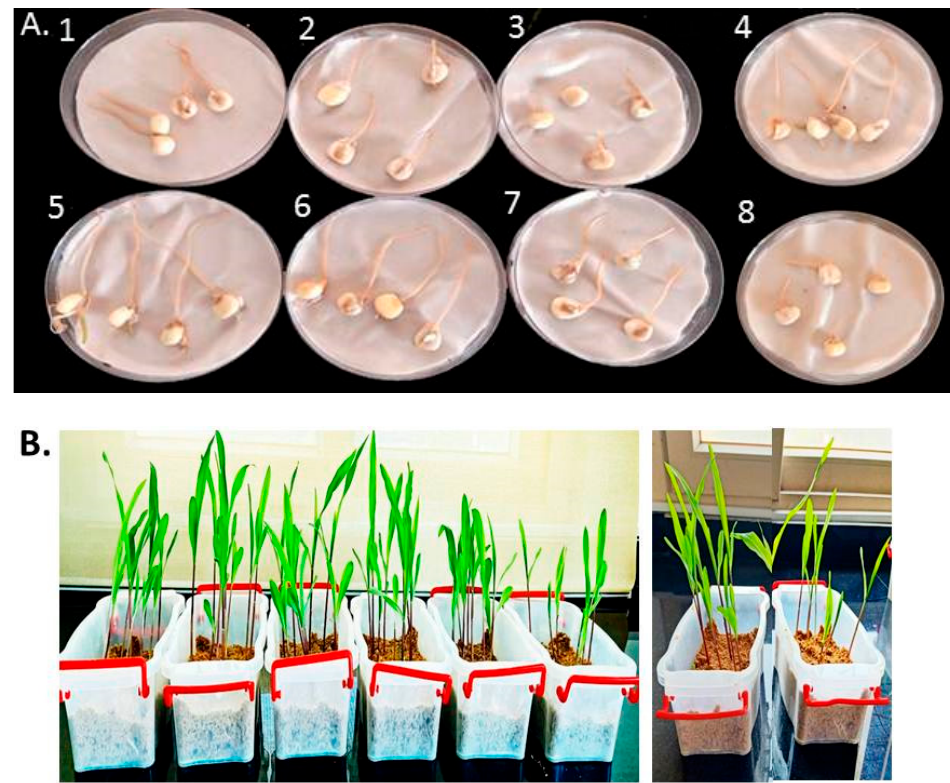
Figure 3. Representative seeds 4 days after treatment with the various L-CNPs concentrations (25, 50, 100, and 500) and refer to L-CNPs concentrations applied to seed for priming ( A ); representative samples 14 days after the treatment with L-CNPs ( B ).